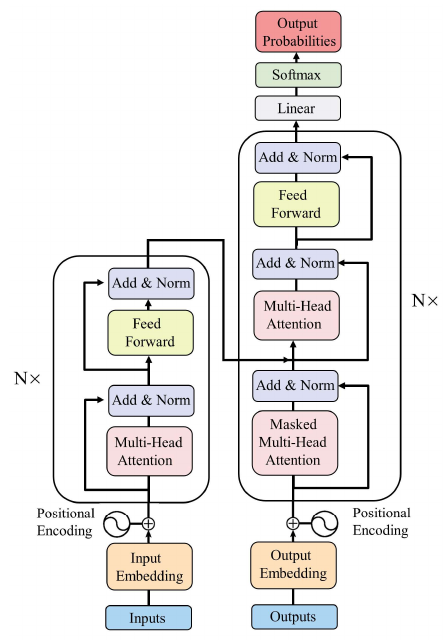
Figure 1. The structure of the Transformer [13]. The ELMo model was proposed in March 2018. The model infers the word vectors cor‑ responding to each word based on the context and is able to understand the meanings of multiple words based on the context. It significantly outperformed the SOTA with regard to six NLP problems [14]. The Google AI language team proposed the BERT